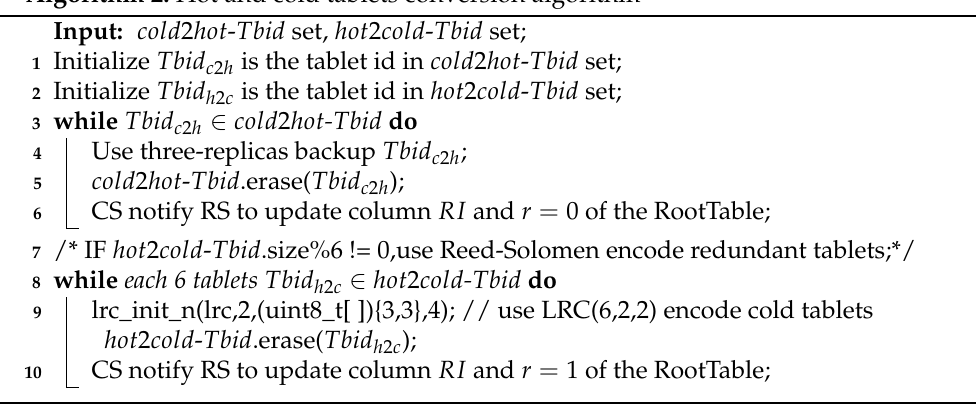
Figure 4. Cold tablet fine-grained coding scheme based on locally repairable code (LRC) code. Stripe 0 consists of the metadata of each tablet. Stripes 1–n consist of the block blocks in the tablet. Other data in the cold tablet are not encoded and can be quickly generated if needed. Algorithm 2: Hot and cold tablets conversion